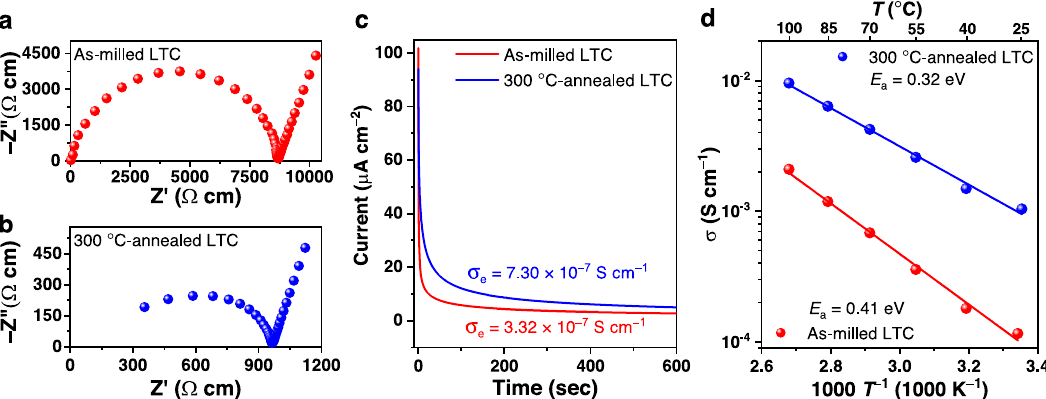
Fig. 1 | Conductivity of LTC with different processing conditions. a , b Nyquist plots of the as-milled ( a ) and 300°C-annealed LTC materials ( b ) at 25°C. c The transient current behavior under an applied 1.0V DC bias on the as-milled and